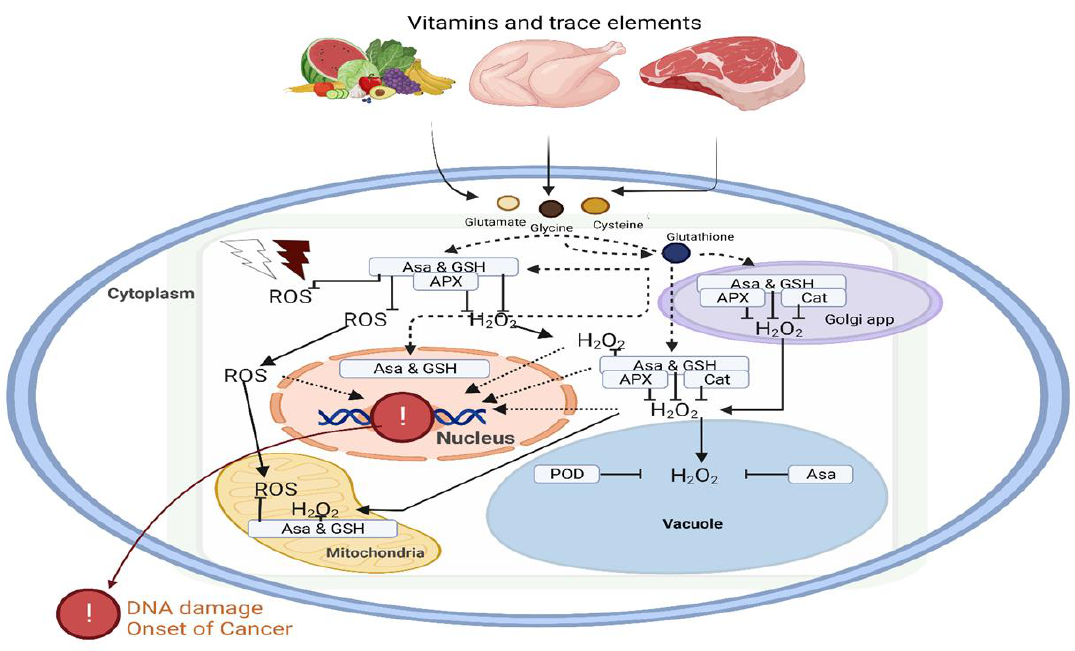
Figure 3. Dietary vitamins and minerals contribute to the antioxidant defense system. The impact of oxidative stress on DNA damage and initiation of carcinogenesis can be regulated by vitamins and trace elements in the different organelles of the cell. Vitamins such as ascorbic acid and reduced glutathione play a key role in oxidative homeostasis. Abbreviations: ROS, reactive oxygen species; APX, ascorbate peroxidase, H 2 O 2 , hydrogen peroxidase; POD, peroxidase; GSH, glutathione peroxidase; Asa; ascorbic